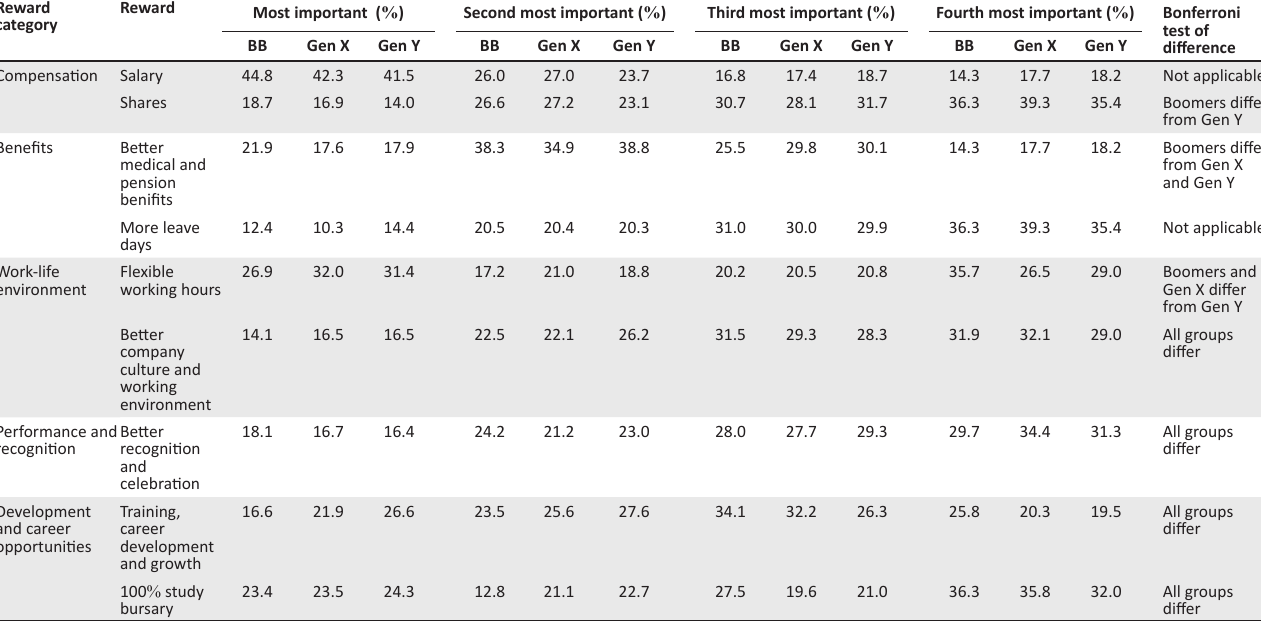
TABLE 8: Preferences in benefits if they were offered by another company. Reward Reward Most important ( % ) category